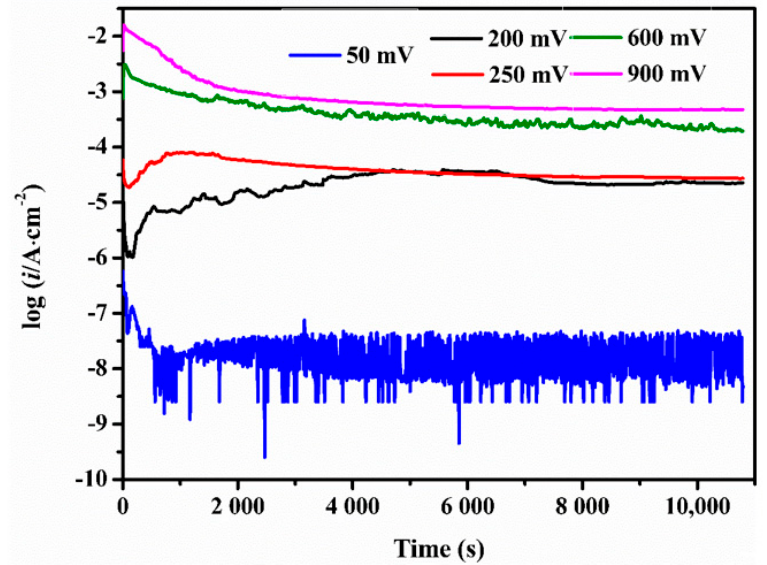
Figure 5. Current densities of the CMSX-4 superalloy during polarization at 50 mV, 200 mV, 250 mV, 600 mV, and 900 mV for 3 h.